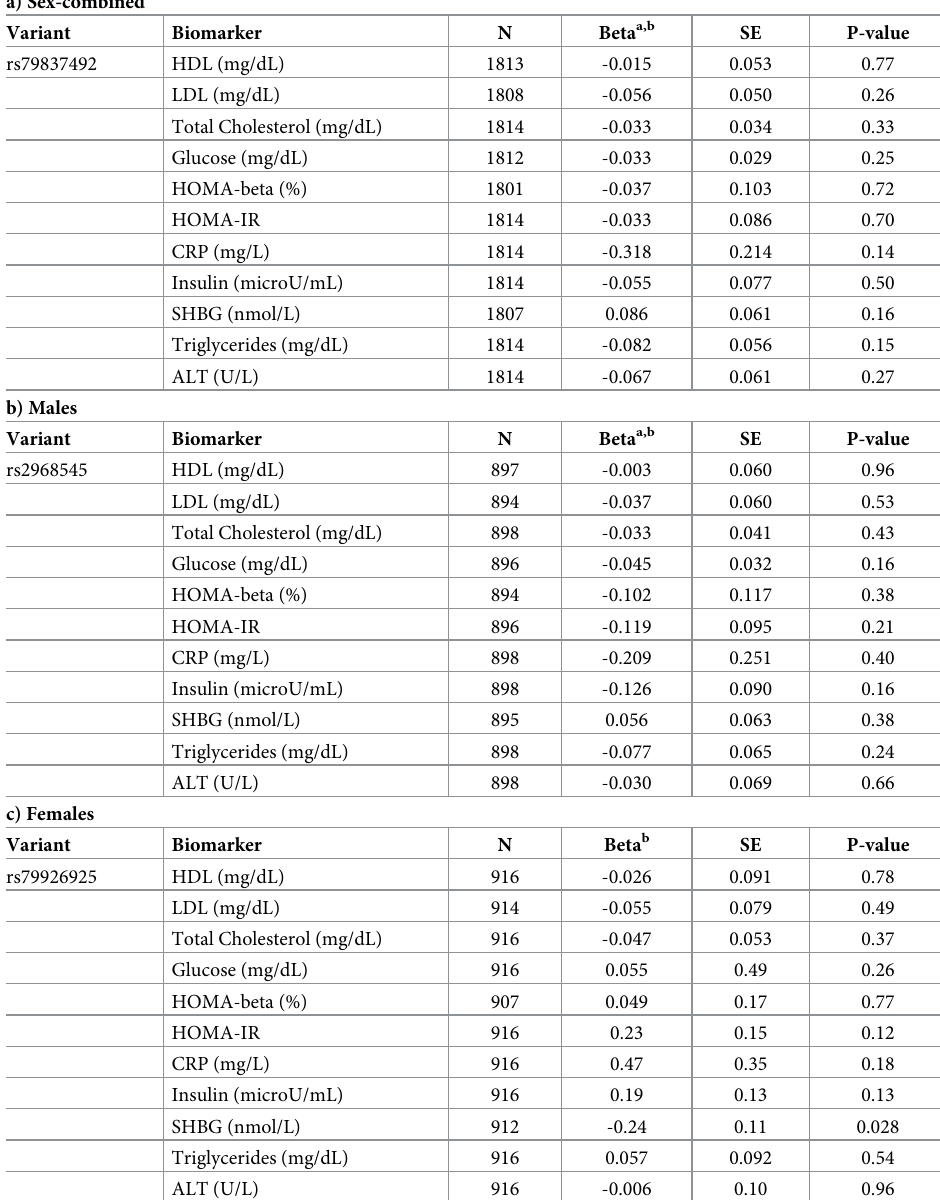
Table 4. The association between lead significant and suggestive variants associated with percent visceral fat and obesity-related biomarkers in the MEC-APS, adjusted for total fat